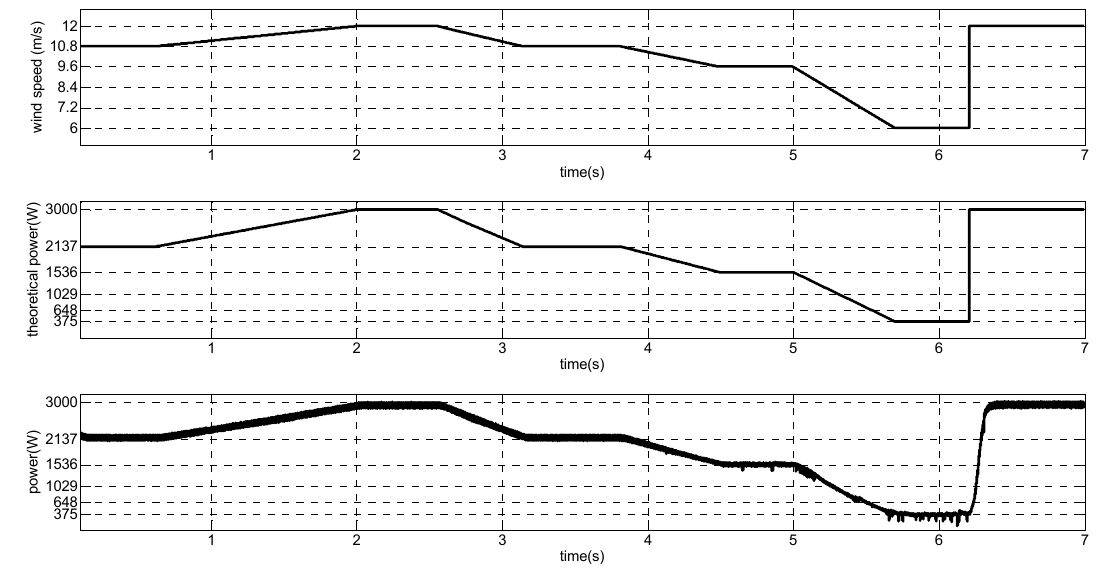
Figure 23. Wind speed with slow variation, theoretical MPP and output power.